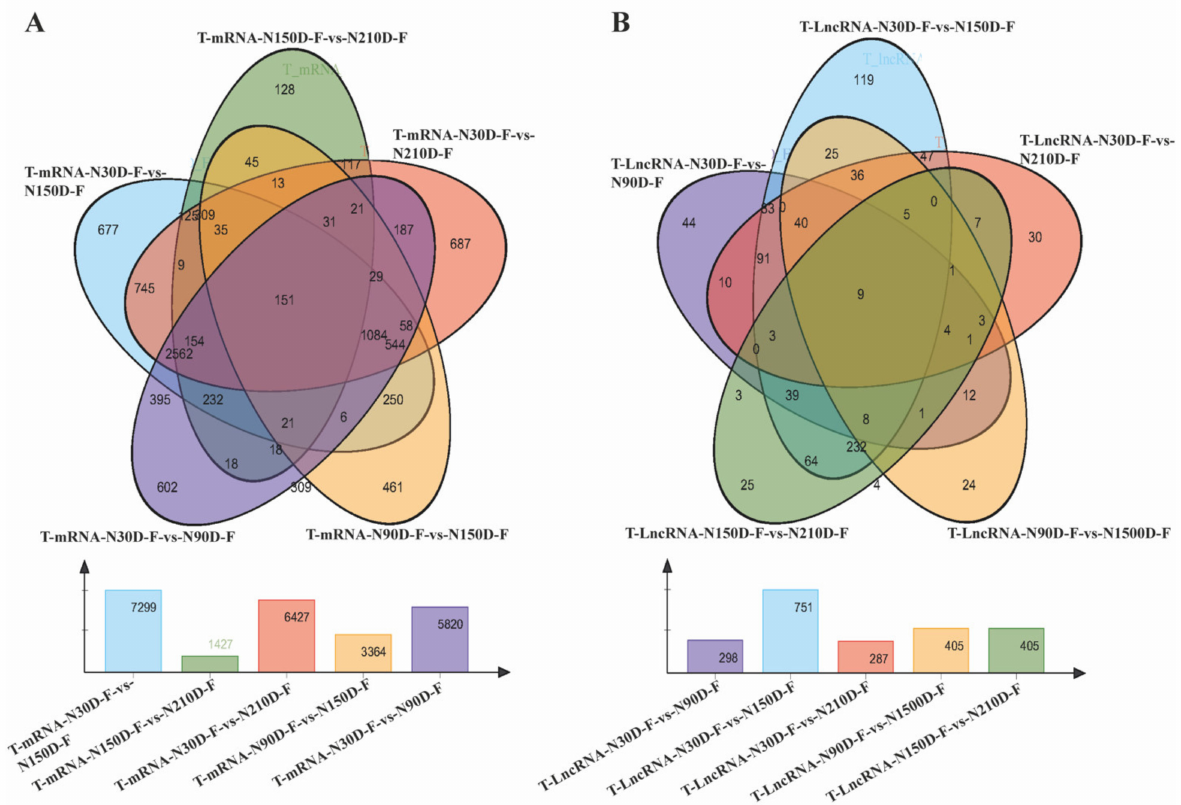
Figure 2. Venn diagram of ( A ) DEmRNAs and ( B ) DElncRNAs of subcutaneous adipose during 4 developmental stages with 3 closed and 2 consecutive